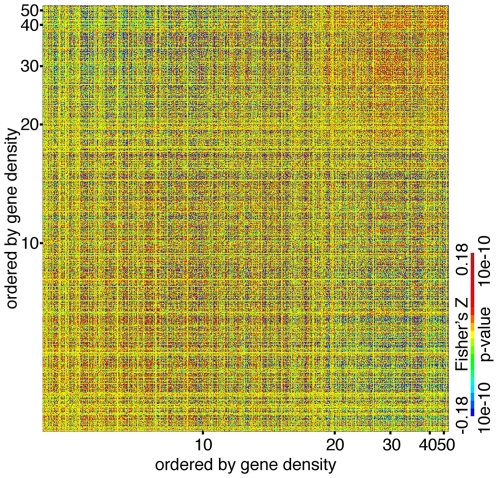
Genome-wide association between coexpression and gene density.Correlation heatmap similar to Figure 3, except that the horizontal and vertical positions are ordered by gene density, not by chromosomal positions. Every 10th genes were sampled for visualization purpose.